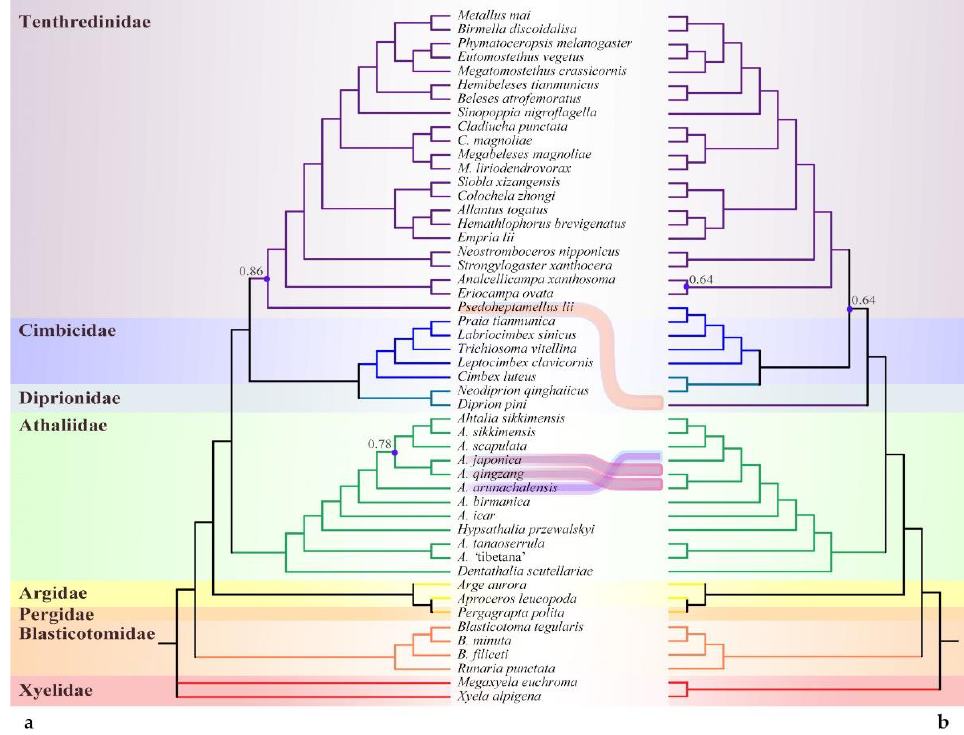
Figure 4. Topological comparison of trees based on single-copy orthologs (SCOs). ( a ) Iqtree; ( b ) PhyloBayes. Bootstrap values and posterior probability support values less than 0.90 are displayed on the trees with blue dots.